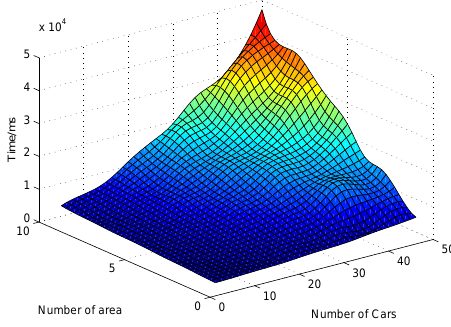
Figure 3. Computational costs on the RSU side.